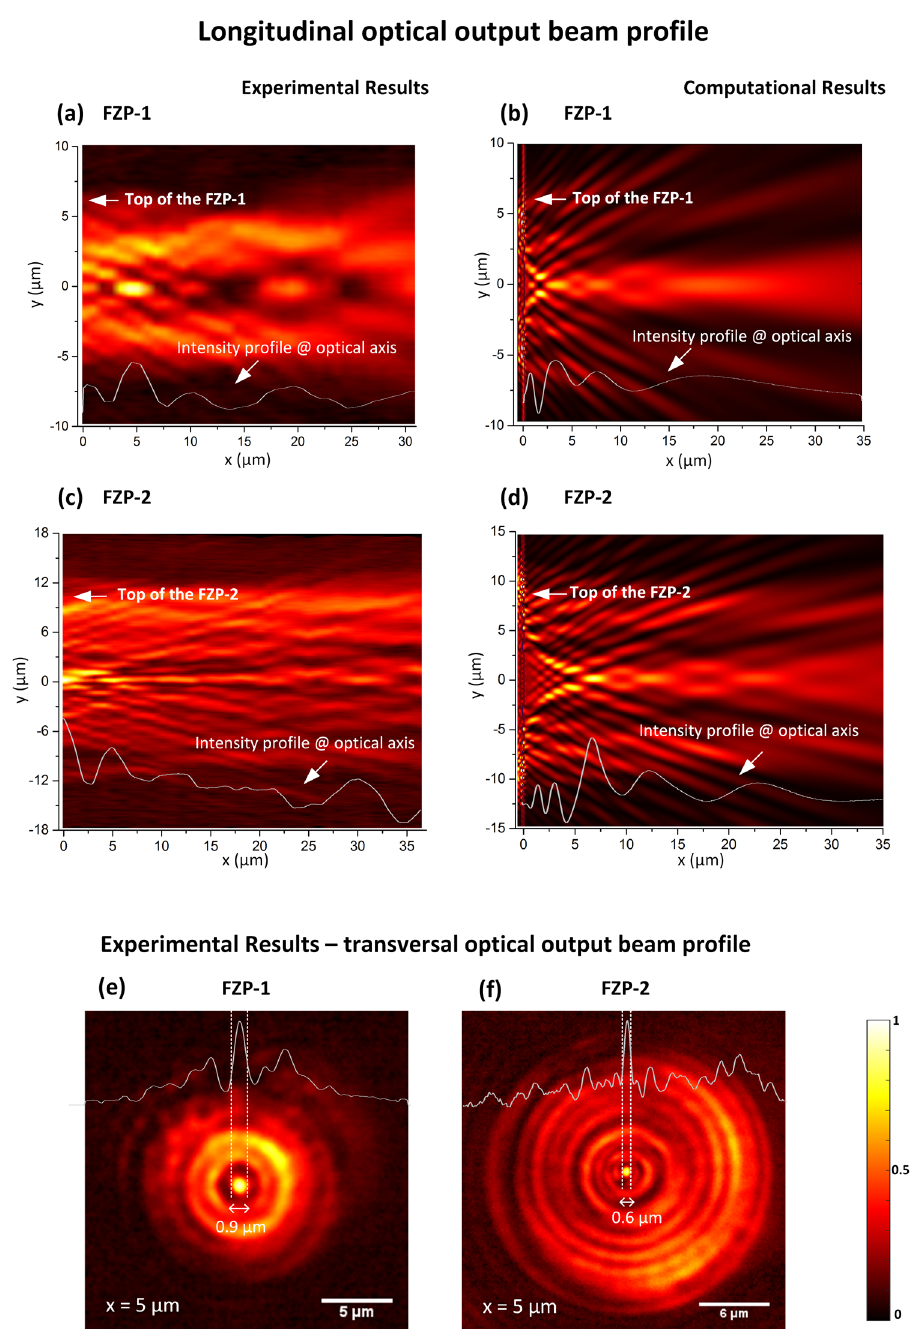
Figure 5. Longitudinal optical output beam profile for FZP-1: ( a ) experimental; ( b ) computational. Longitudinal optical output beam profile for FZP-2: ( c ) experimental; ( d ) computational. Transversal optical output beam profile at the main focal point: ( e ) FZP-1; ( f )